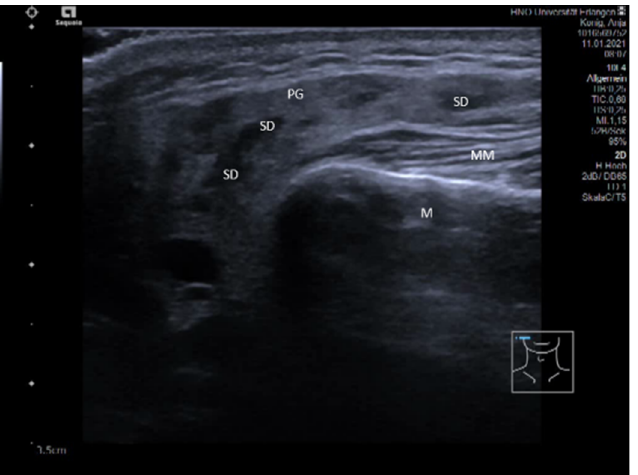
Figure 10. Eosinophilic sialodochitis in the right PG. The parenchyma is hypoechoic and characterized by multiple anechoic formations within the parenchyma corresponding to multiple dilations of Stensen’s duct, giving it a “leopard-skin” appearance. These are oriented along the course of the duct and do not typically have a rounded shape as in sialectatic sialadenitis and are not perfused. Abbreviations: PG, parotid gland; M, mandible; MM, masseter muscle; SD, Stensen’s duct.